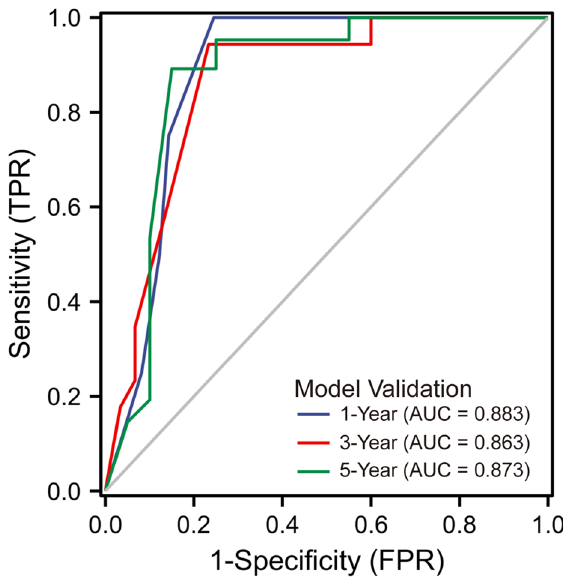
Figure 8. Based on an independent external validation cohort of 53 OS samples from the GSE21257 dataset, the time-dependent ROC curve demonstrated the model’s outstanding predictive efficacy for prognosis of patients with